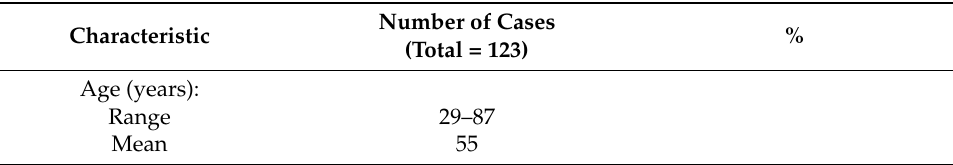
Table 1. Clinicopathological characteristics of the study